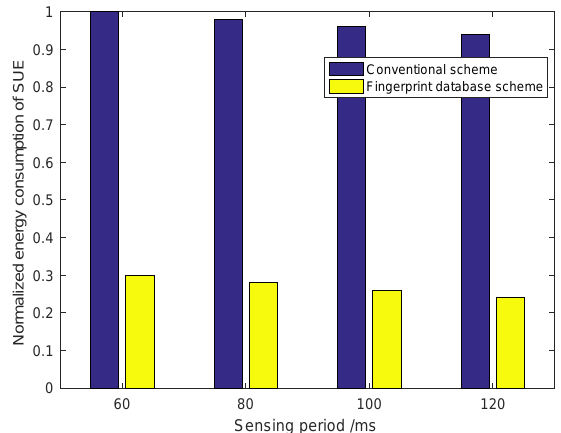
Figure 8. Power consumption of conventional sensing scheme and the wireless fingerprint database (WFPD) aided scheme with different sensing period T s .